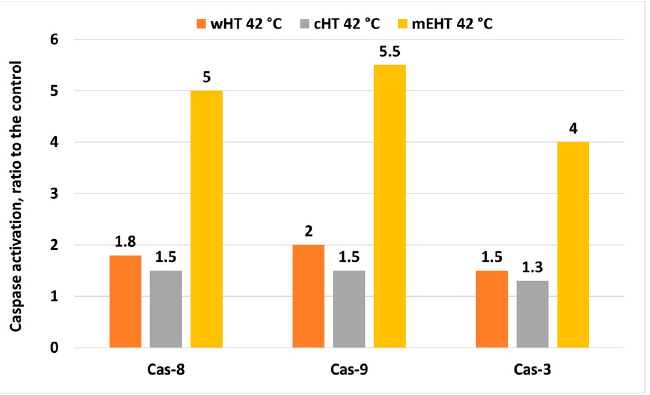
Figure 12. Apoptosis markers: cCas-3, -8, and -9, are increased in samples treated with mEHT compared with samples treated with water heating (wHT) and capacitive heating (cHT) [75].